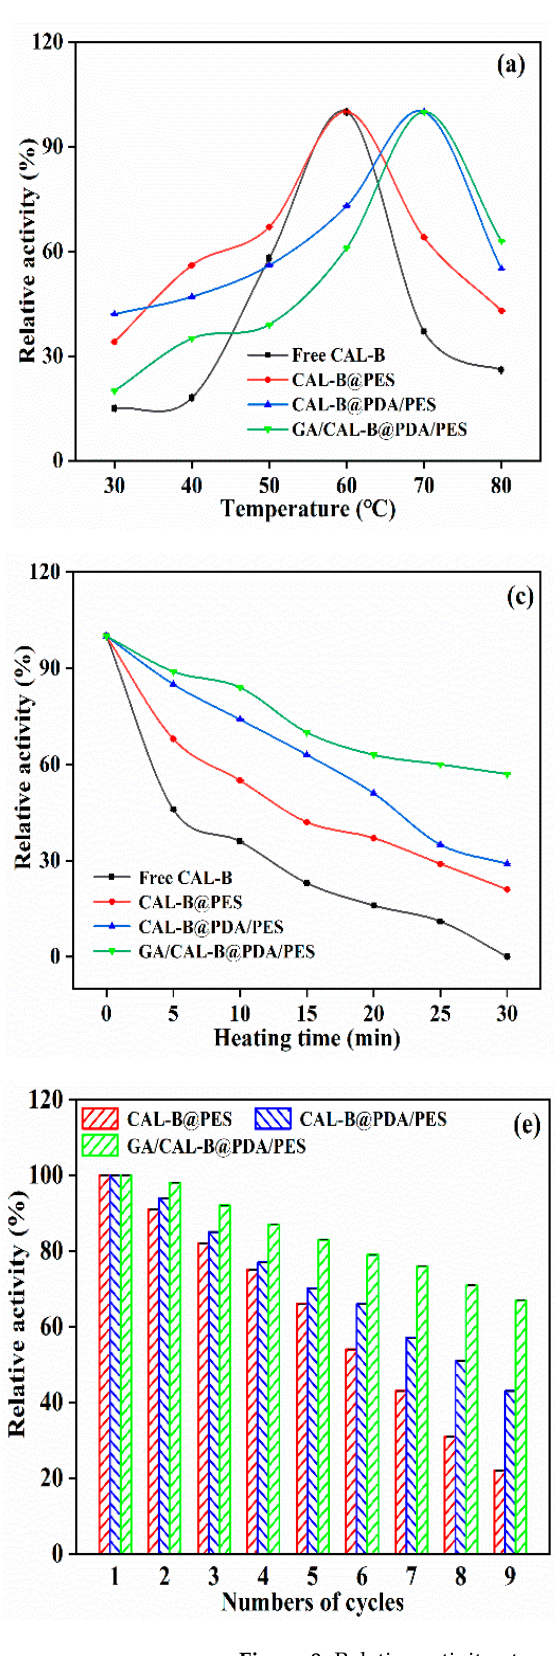
Figure 9. Relative activity at various temperatures ( a ), pH ( b ), heating time ( c ), storage time ( d ) and numbers of cycles ( e ).